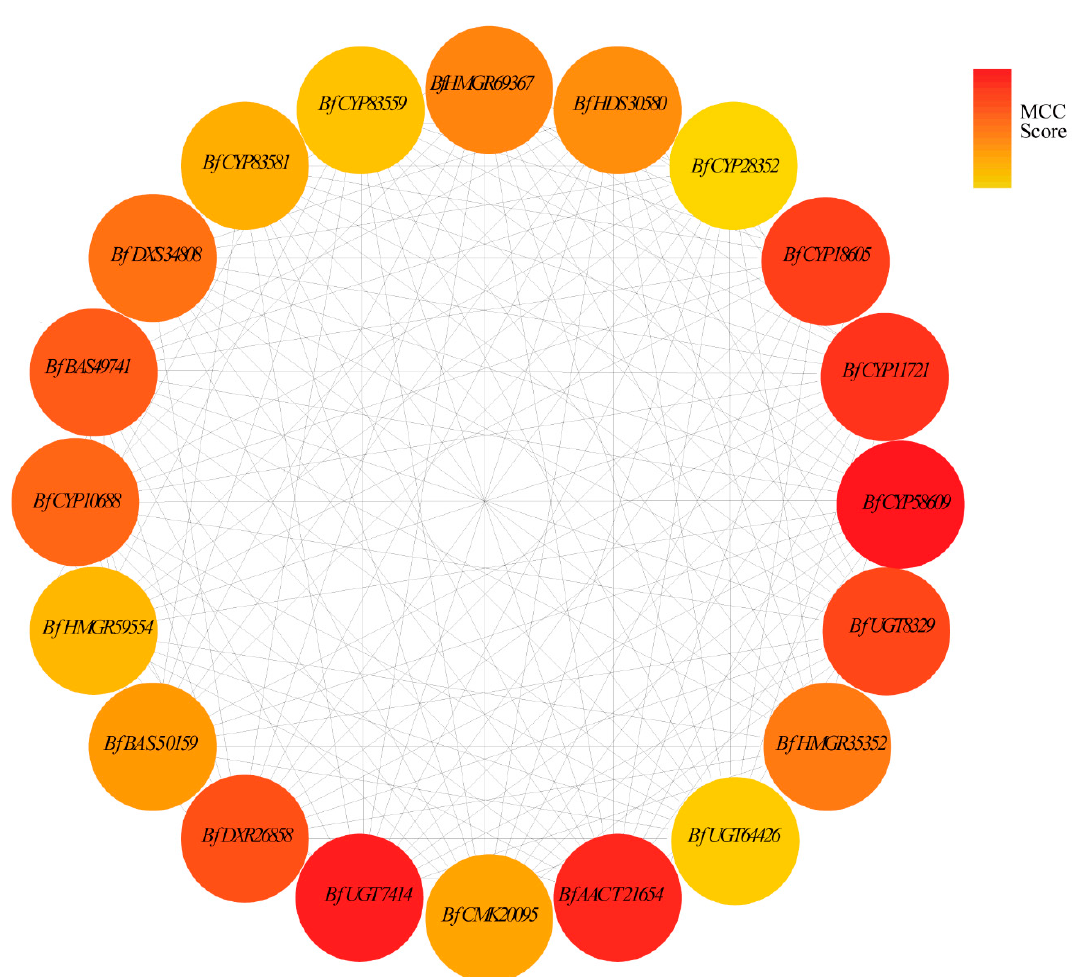
Figure 5. Hub genes of putative triterpenoid biosynthesis pathway. The MCC (maximal clique centrality) algorithm identified hub genes in PPI networks. The red node represents the high MCC score gene, and the yellow represents the low score gene.